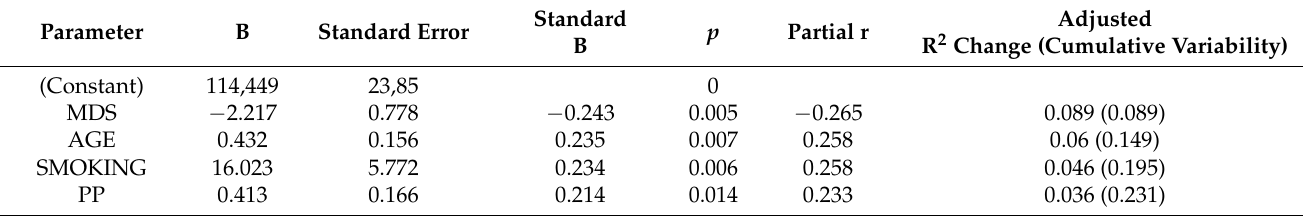
Figure 2. Distribution of cardiac geometry patterns ( n = 127 chronic kidney disease patients on dialysis).